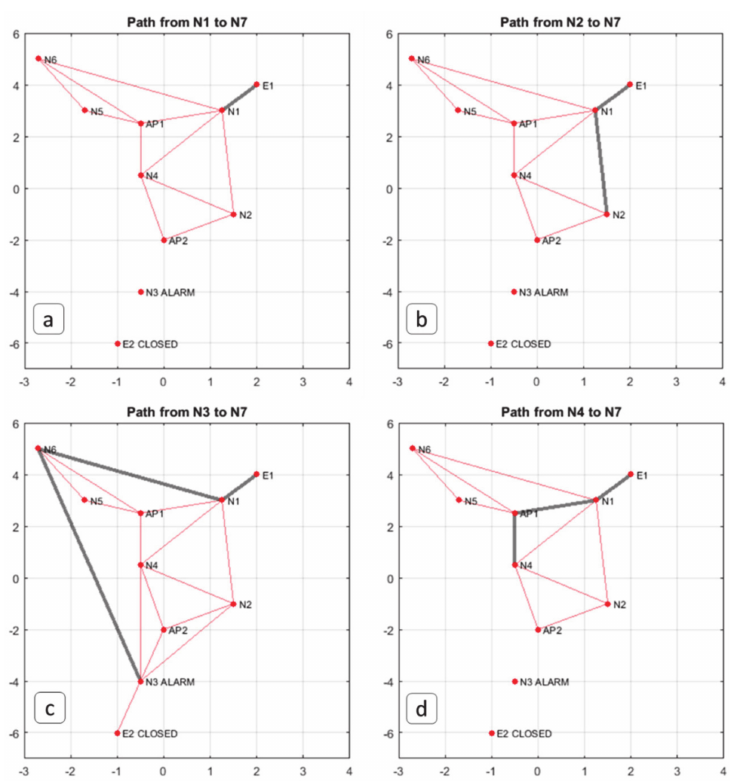
Figure 14. Example of the safest and fastest paths provided by the Algorithm 3 in case of an environmental / structural alarm at node 3 (N3), which can be used by people at ( a ) node 1 (N1), ( b ) node